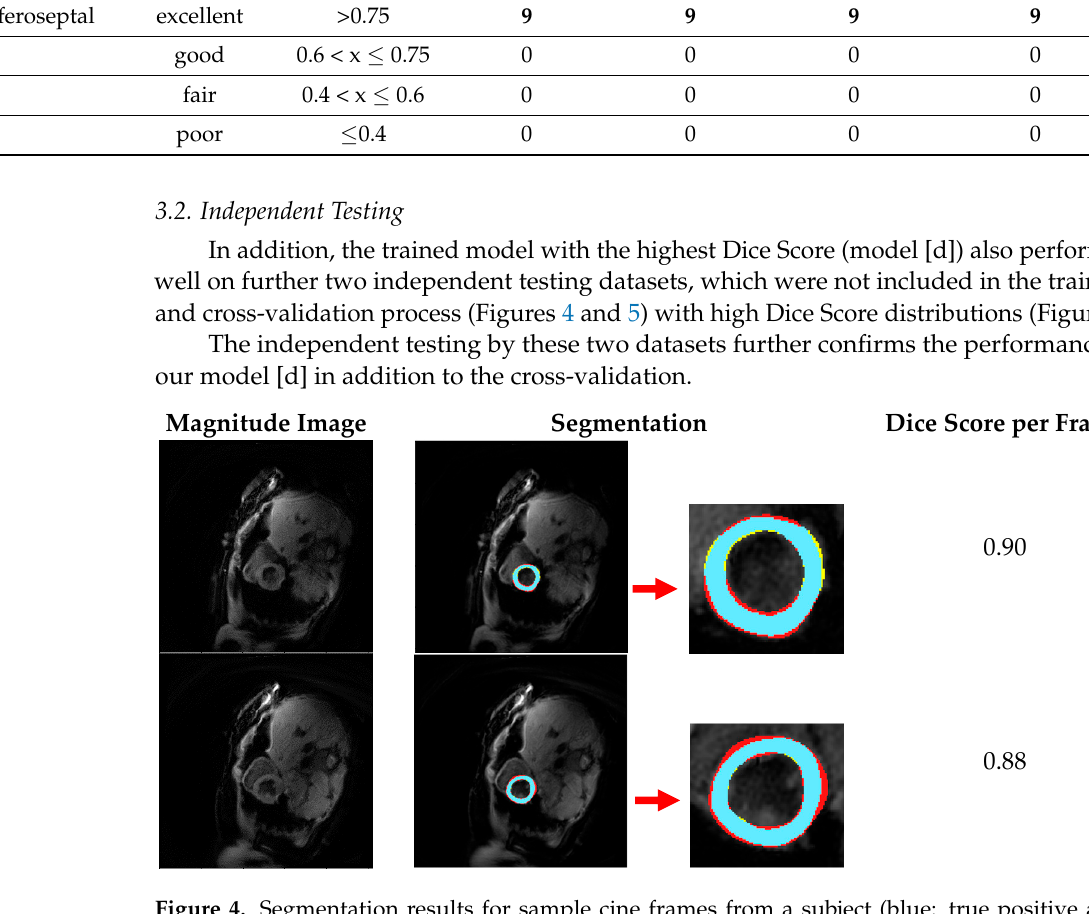
Figure 4. Segmentation results for sample cine frames from a subject (blue: true positive auto- mated segmentation; yellow: false positive automated segmentation; red: false negative automated segmentation).